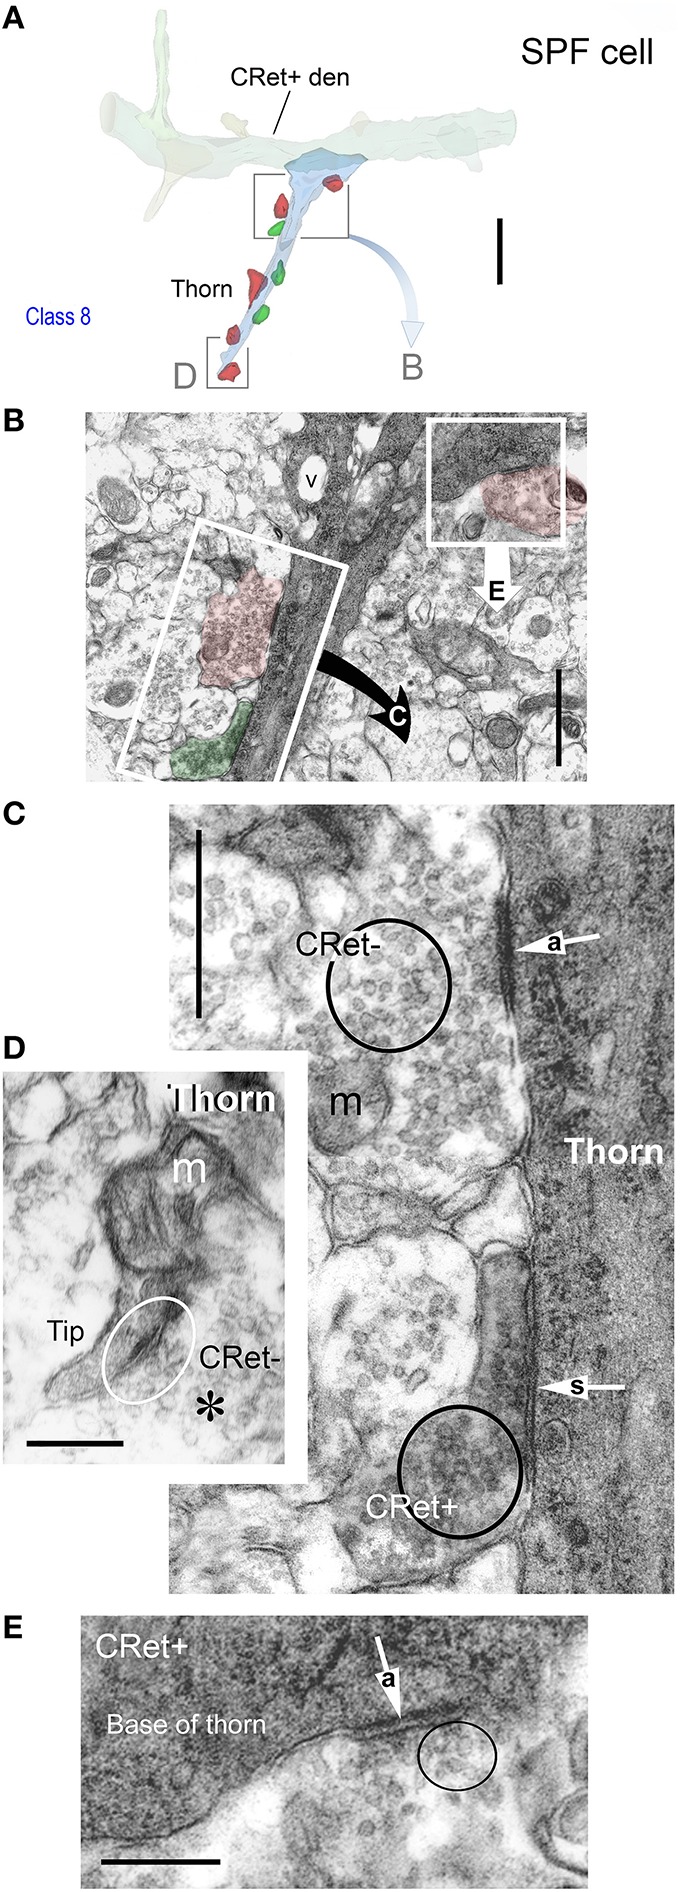
(A) 3D ultrastructural reconstruction of a SPF cell dendritic segment with a long thorn-like process (blue) emerging from the shaft. Only pre-synaptic boutons apposing the thorn are indicated: red boutons form A-type synapses, green boutons S-type junctions. The framed areas are shown in (B,D). Scale bar = 5 μm. (B) Ultrastructure of the framed area in (A). [The framed regions in this figure are shown in (C,D), respectively]. Note vacuole (v) in thorn base. Scale bar = 1 μm. (C) An unlabeled (CRet-) bouton establishes an A-type (“a” white arrow) synaptic junctions with the CRet+ immunolabeled dendritic thorn. A CRet+ labeled bouton make a S-type (“s” white arrow) with the same target. Clusters of synaptic vesicles are indicated in the pre-synaptic elements (black circles). Mitochondrion, m. Scale bar = 0.5 μm. (D) Ultrastructural features of the framed area in (A). The tip of the dendritic thorn is filled with a mitochondrion and the narrow distal portion receives an A-type synaptic contact (encircled) from an unlabeled (CRet-) bouton. Synaptic vesicles (asterisk). Scale bar = 0.25 μm. (E) An unlabeled bouton located at the base of the dendritic thorn (see A) establishes an A-type (“a” white arrow) synaptic junction (encircled) with the CRet+ labeled dendritic process. Scale bar = 0.25 μm.